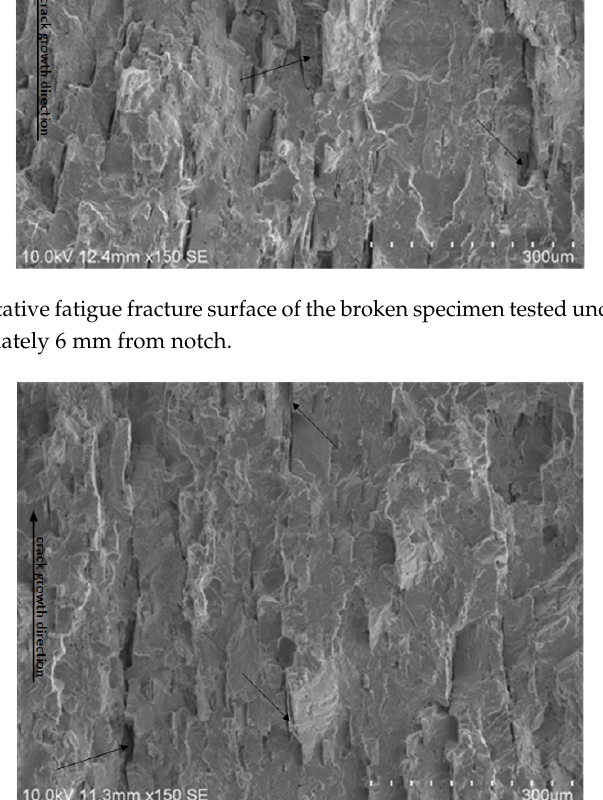
Figure 14. Representative fatigue fracture surface of the broken specimen tested under mode I condition (R = 0.5)—approximately 6mm from notch.